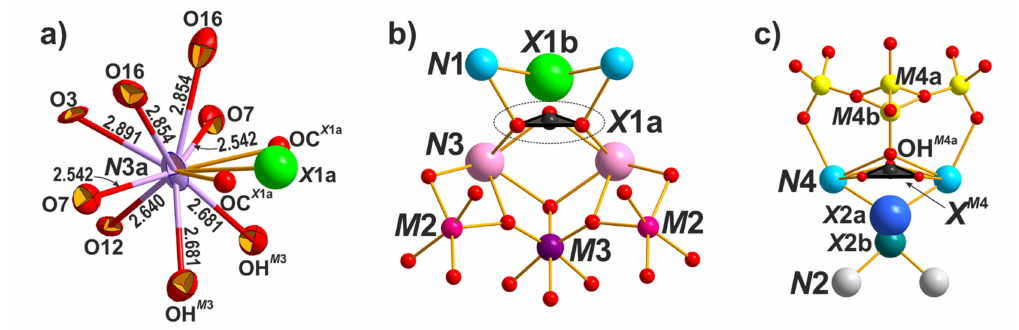
Figure 6. Local coordinational environments of the N 3a site ( a ), the X 1 site ( b ), and the X 2 site ( c